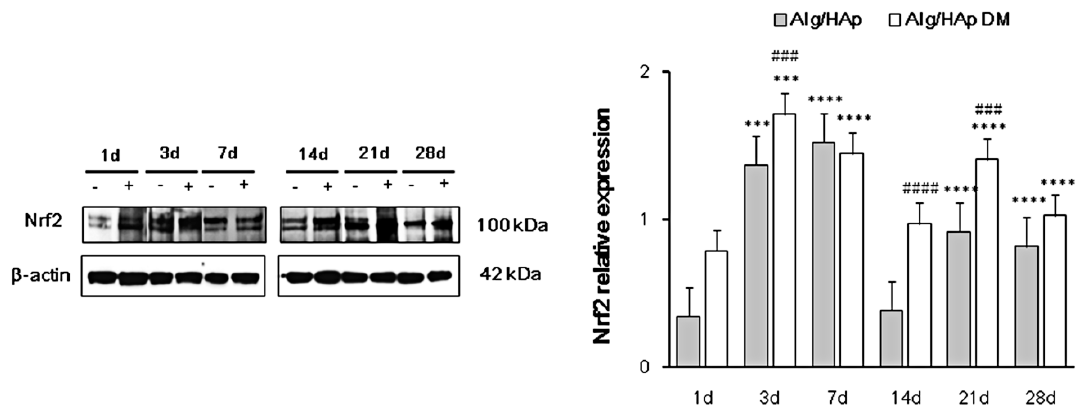
Figure 3. Nuclear factor erythroid 2-related factor 2 (Nrf2) expression levels in DPSC growth onto Alg/HAp scaffolds. Typical results of Nrf2 protein expression by Western blotting of three independent experiments. β -actin was used as a protein content marker. The bar graph shows densitometric values expressed as the mean percentage ± SEM ( n = 3) of integrated optical densities of protein bands normalized on β -actin. *** p < 0.005 between Alg/HAp at three days and Alg/HAp at one day; *** p < 0.005 between Alg/HAp with DM at three days and Alg/HAp at one day; **** p < 0.001 between Alg/HAp at seven, 21, and 28 days and Alg/HAp at one day; **** p < 0.001 between Alg/HAp with DM at seven, 21, and 28 days and Alg/HAp at one day; ### p < 0.005 between Alg/HAp with and without DM at three and 21 days; #### p < 0.001 between Alg/HAp with and without DM at 14 days.